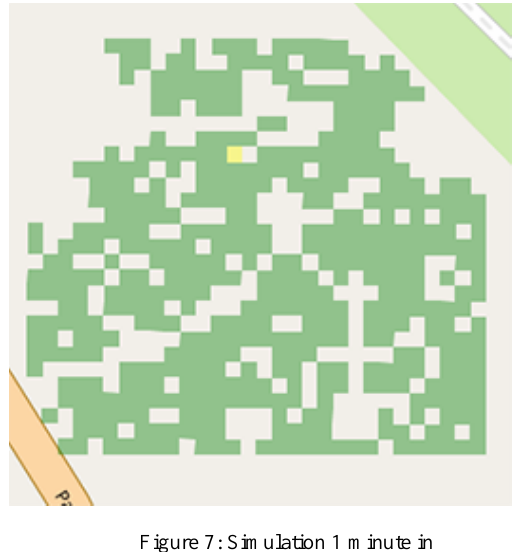
Figure 7: Simulation 1 minute in